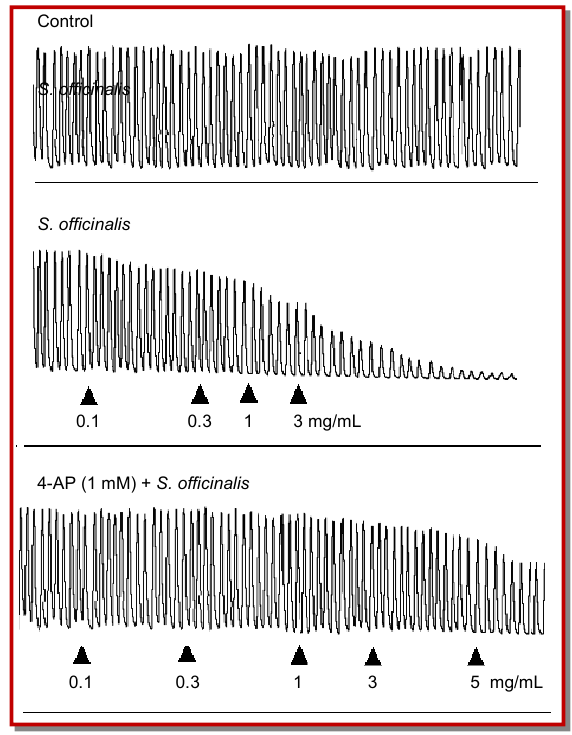
Figure 1: Tracing showing inhibitory effect of the crude extract of S. officinalis on spontaneous contractions in the absence and presence of K+ channel blocker (4-AP)